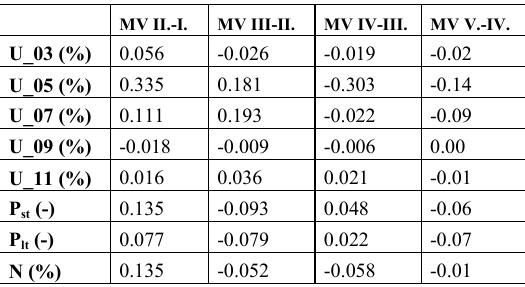
T RENDS OF CHANGES IN THE SELECTED VOLTAGE QUALITY PARAMETERS IN THE MV NETWORKS MV II.-I.